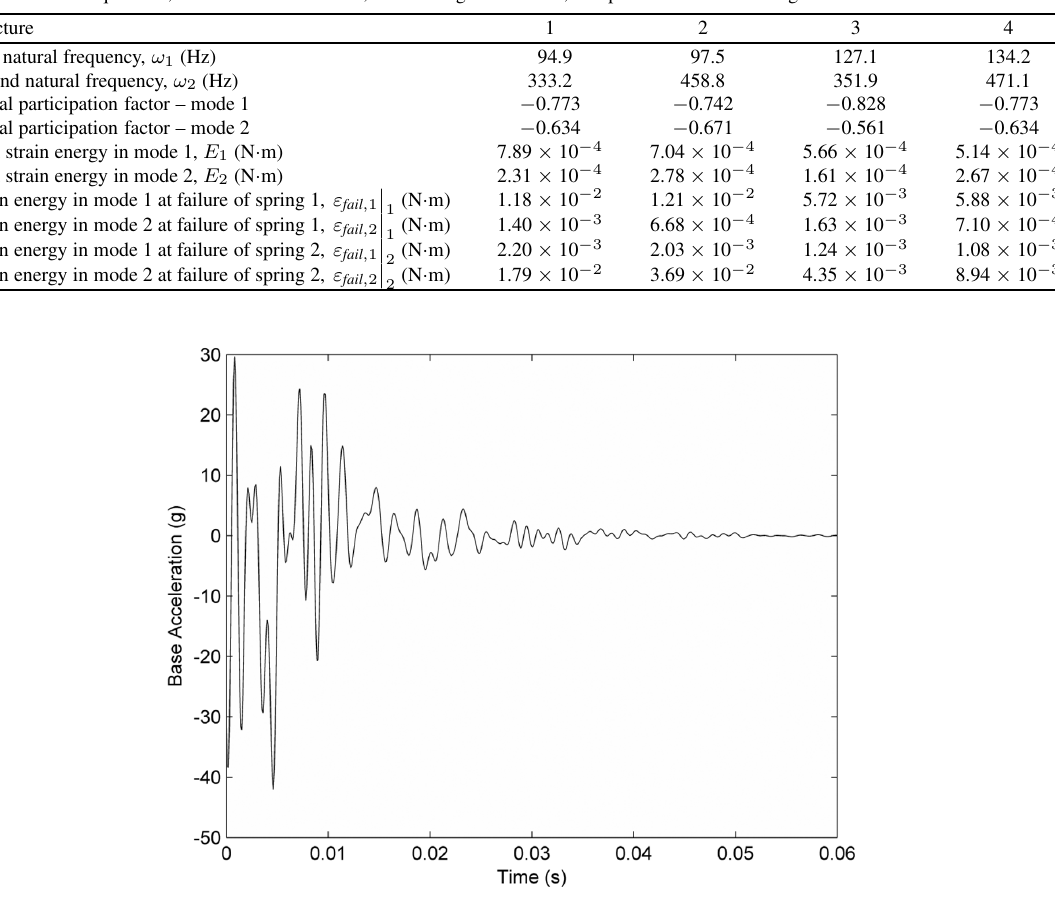
Fig. 2. Nominal base acceleration applied to two DOF